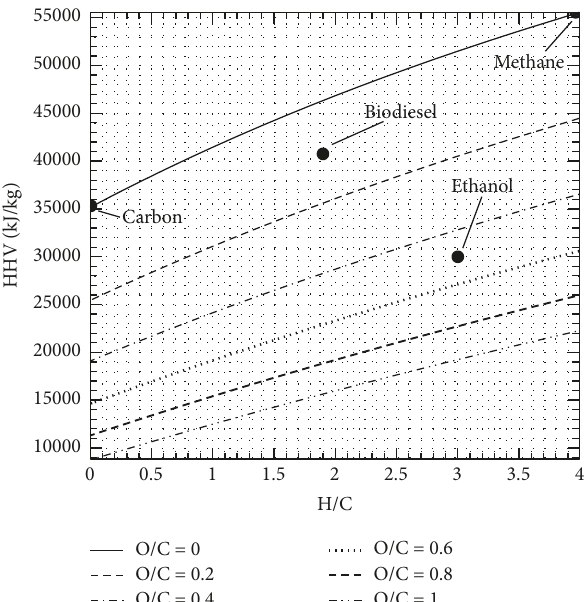
Figure 1: Estimated variation of HHV with fuel composition using Boie equation. HHV decreases with increase in oxygen content in the fuel. Multiply HHV in kJ/kg by 0.43 to obtain BTU/lb. H/C: hydrogen to carbon atom ratio and O/C: oxygen to carbon atom ratio